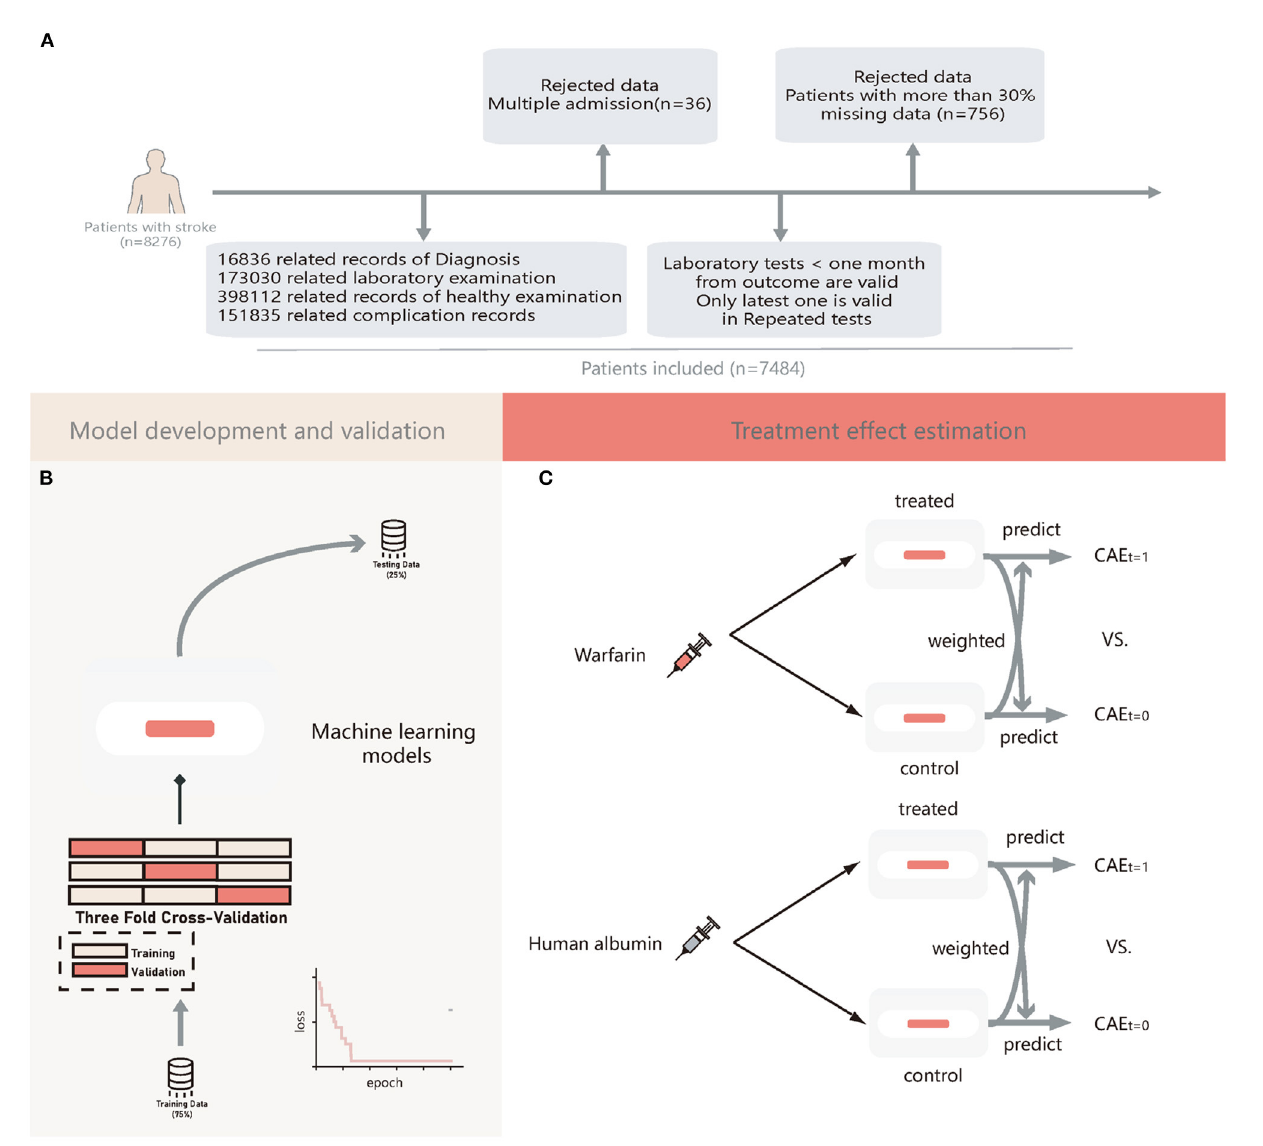
FIGURE1 The flow chat of patients’ enrollment, model development and validation, and treatment effect estimation. (A) Flow chart of patients’ enrollment; (B) Flow chart machine learning models development and validation; (C) Flow chart of estimation of treatment heterogeneity effects. CATE, conditional average treatment effect; t = 1, patients treated with warfarin or human albumin; t = 0, patients not treated with warfarin or human